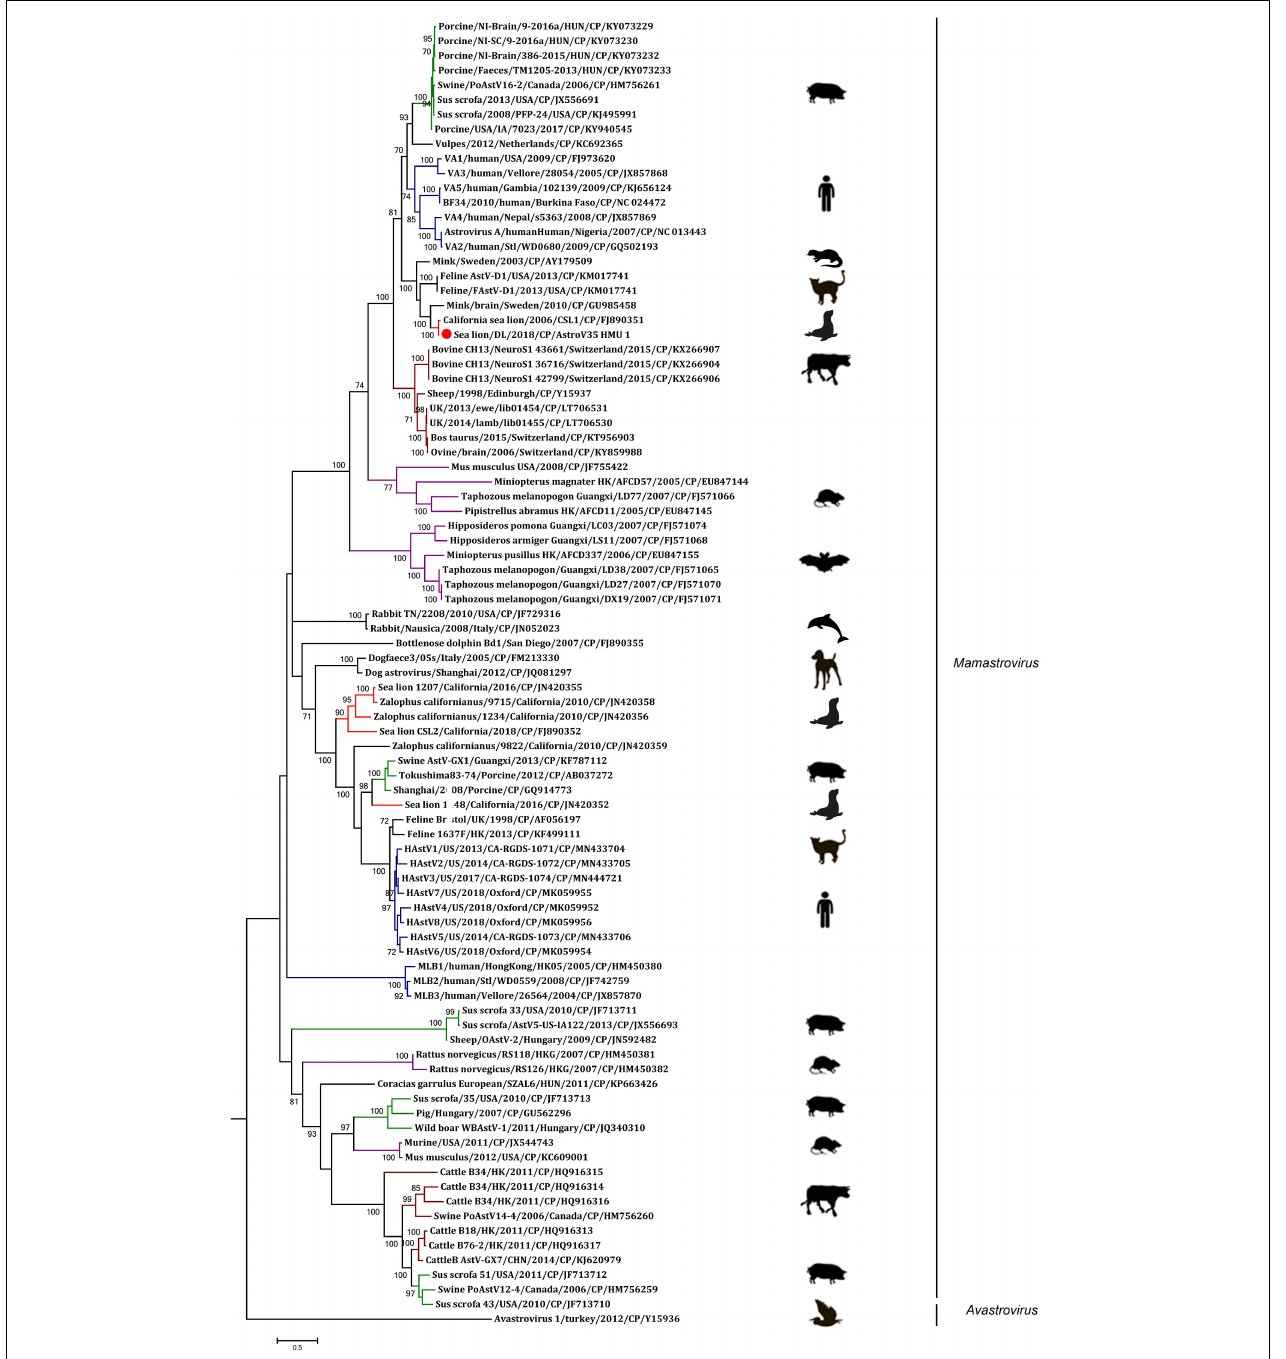
FIGURE 4 | Phylogenetic analyses of CP regions of AstroV-HMU-1 with reference sequences. Maximum likelihood (ML) mtREV with Freqs (+F) model and γ -distributed with invariant sites (G + I) with 1,000 bootstrap replicates performed in MEGA6. Novel astrovirus is indicated by red circles ( • ). Bootstrap values are shown on